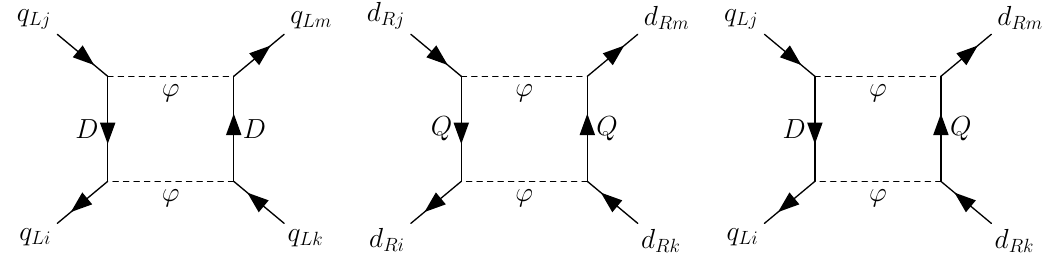
Figure 4 . Box diagrams induced by the presence of vector-like